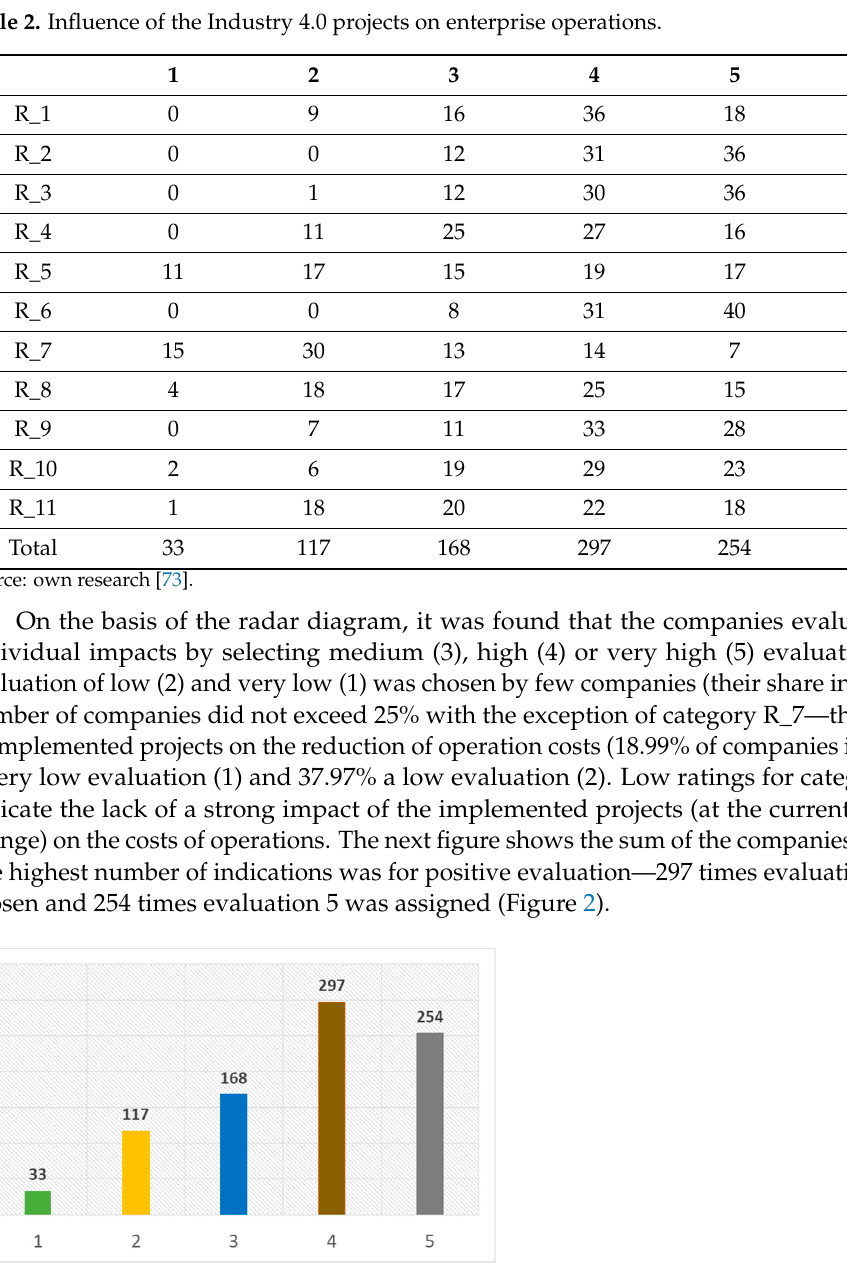
Table 2. Influence of the Industry 4.0 projects on enterprise operations.